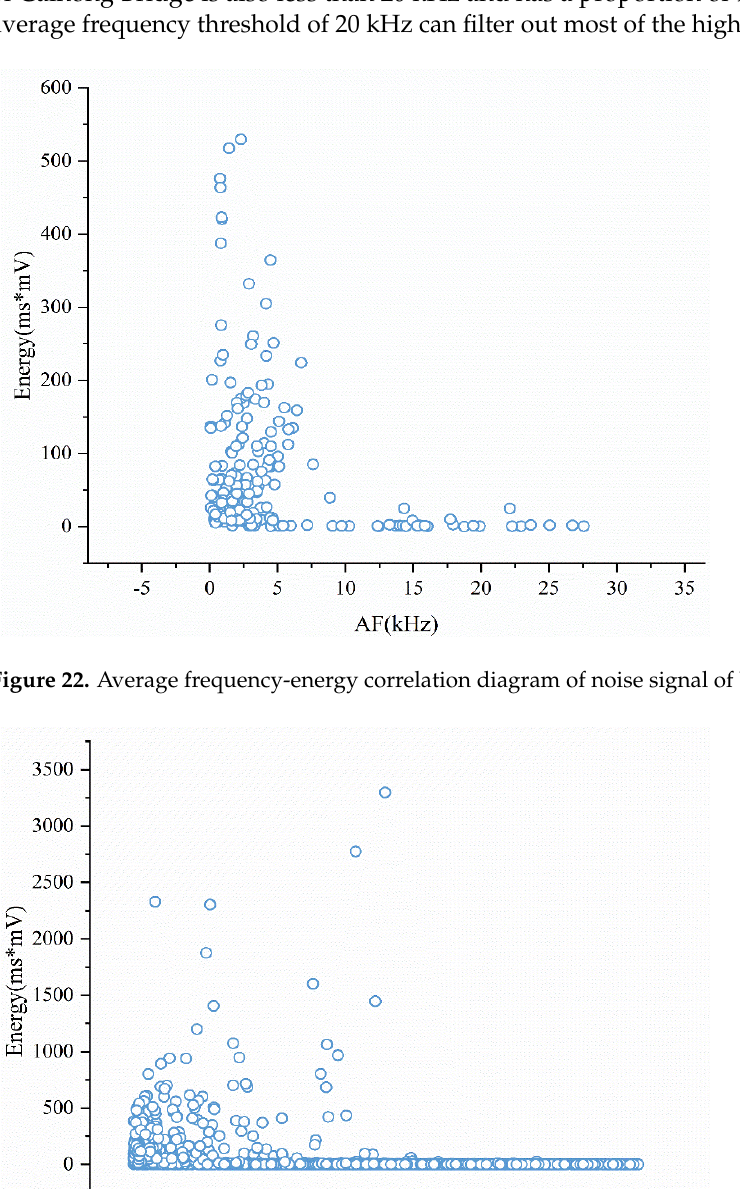
Figure 21. Time domain and frequency domain waveform diagram of noise signal of Caihong Bridge. ( a ) Signal time domain diagram; ( b ) signal frequency domain diagram.